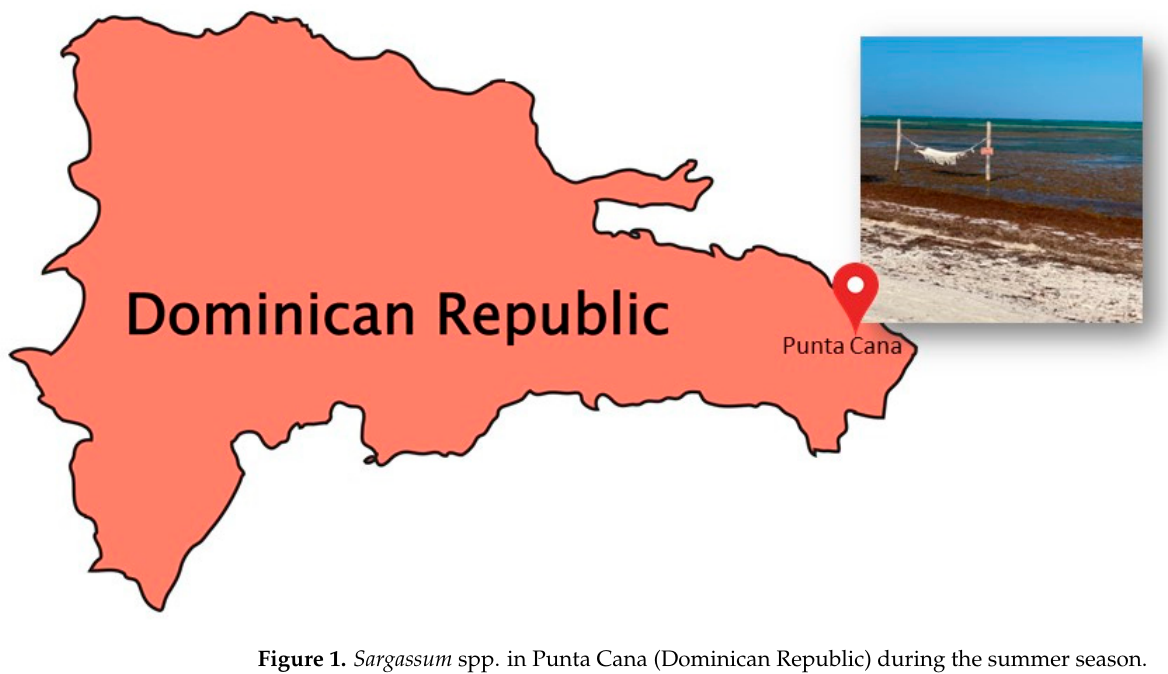
Figure 1. Sargassum spp. in Punta Cana (Dominican Republic) during the summer season.